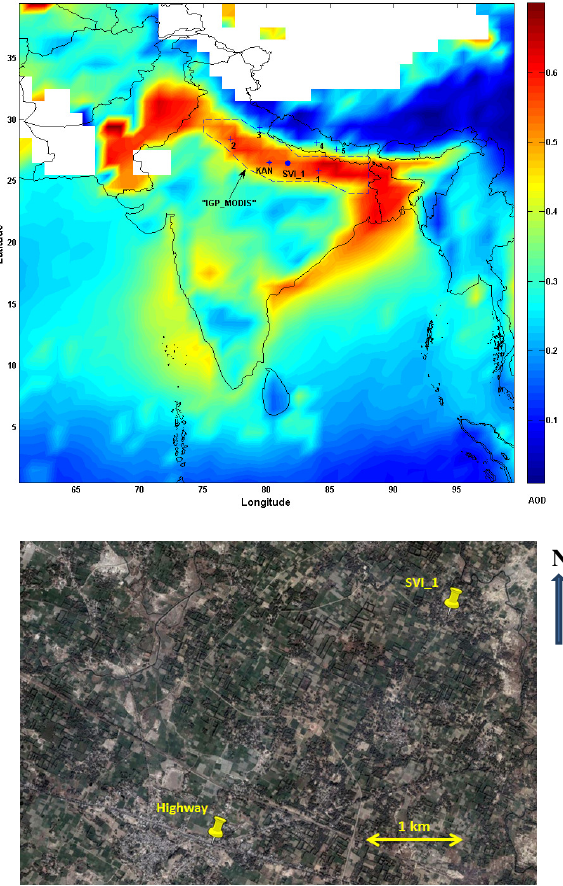
Fig. 1. (Above) MODIS TERRA mean aerosol optical depth (AOD) for the period 1 October 2009 to 14 April 2010 over India. SVI 1 (Surya village) represents our sampling location. KAN represents neighbouring urban (130km away from SVI 1) AERONET site at Kanpur (26.30 0 N, 80.31 0 E). Other AERONET sites in the IGP re- gion are shown as 1 (Gandhi College; 25.52 0 N, 84.07 0 E), 2 (Gual Pahari; 28.25 0 N, 77.09 0 E) and 3 (Nainital; 29.21 0 N, 79.27 0 E) lo- cated in India; 4 (Pokhara; 28.09 0 N, 83.58 0 E) and 5 (Kathmandu University; 27.36 0 N, 85.32 0 E) located in Nepal. Dashed line repre- sents the “IGP MODIS” region used for calculating regional mean AOD (using MODIS). (Below) Satellite view showing locations of our two sampling sites; SVI 1 and